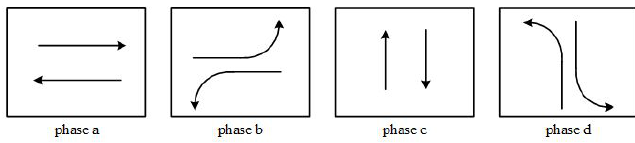
Figure 2. Phases in an intersection.